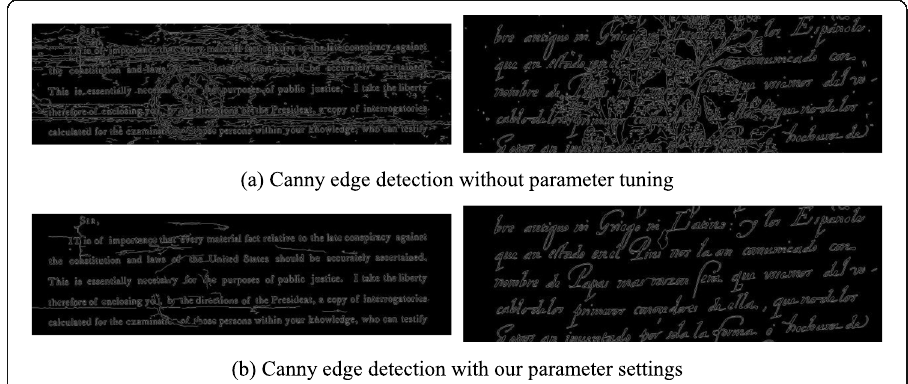
Fig. 3 Text edge maps constructed using Canny edge detector with and without our parameter